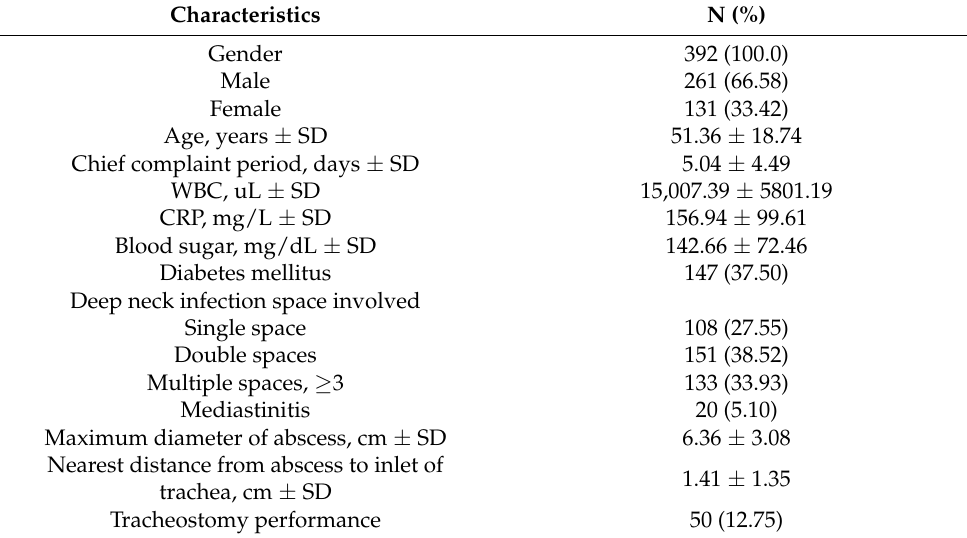
Table 1. Clinical characteristics of the 392 patients with deep neck